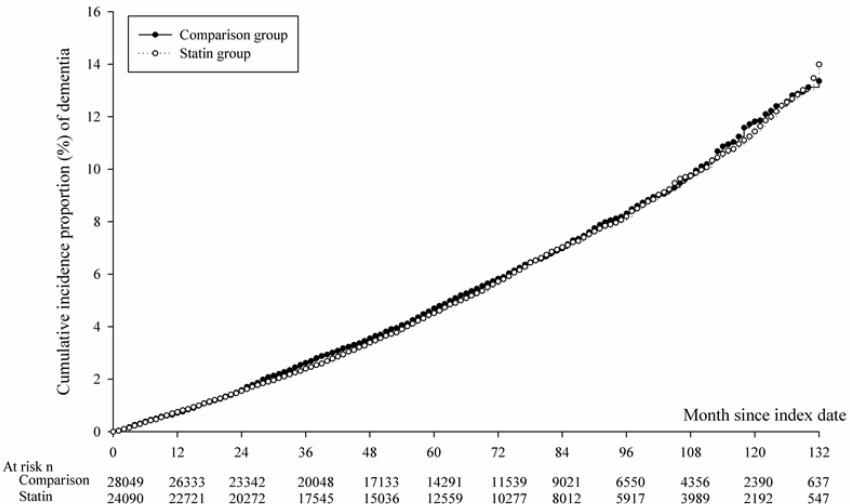
Figure 2. K-M curves of incidence probability of dementia in patients with chronic kidney disease, log rank p = 0.6577. Median of follow up time: Non-statin = 61 months, Statin user = 62.